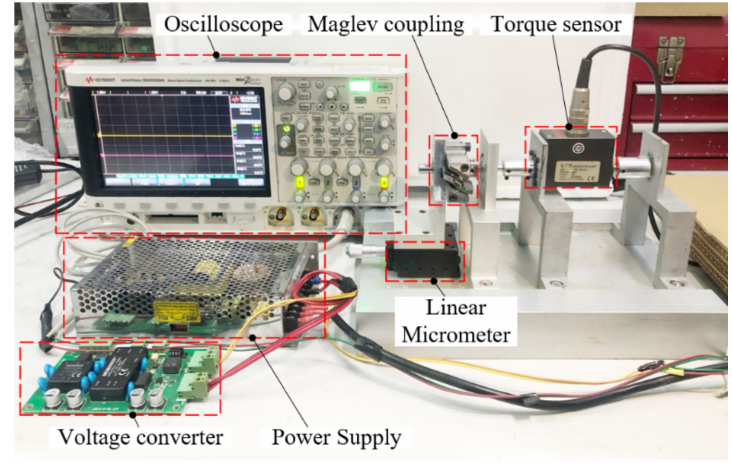
Figure 16. Experimental platform for prototypes of maglev coupling.